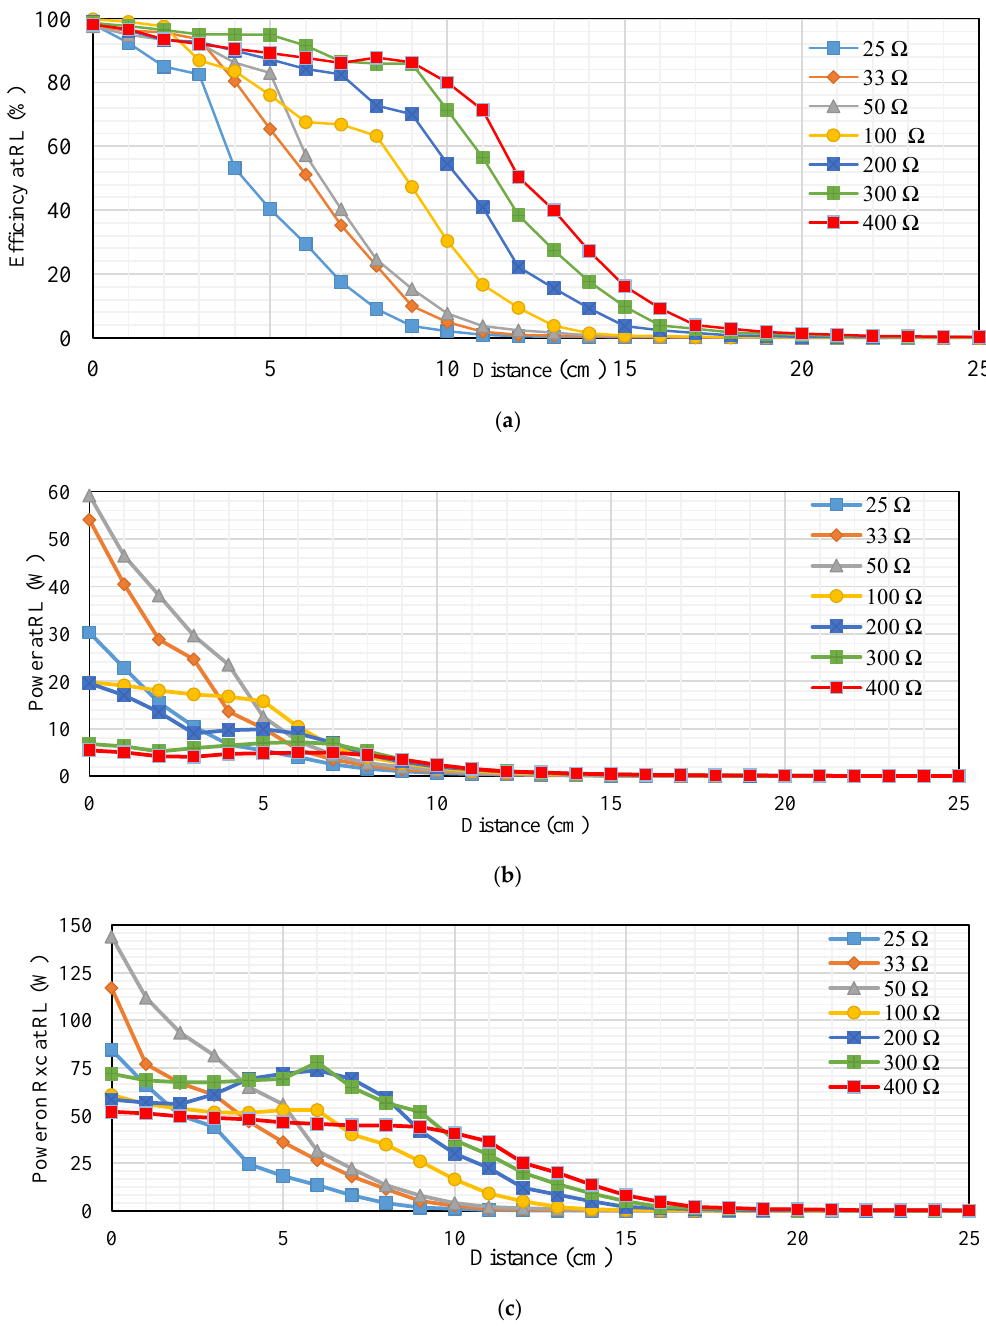
Figure 17. Performance at different loads for third topology: ( a ) transfer efficiency at RL, ( b ) transfer power at RL, and ( c ) transfer efficiency on Rx C at RL.